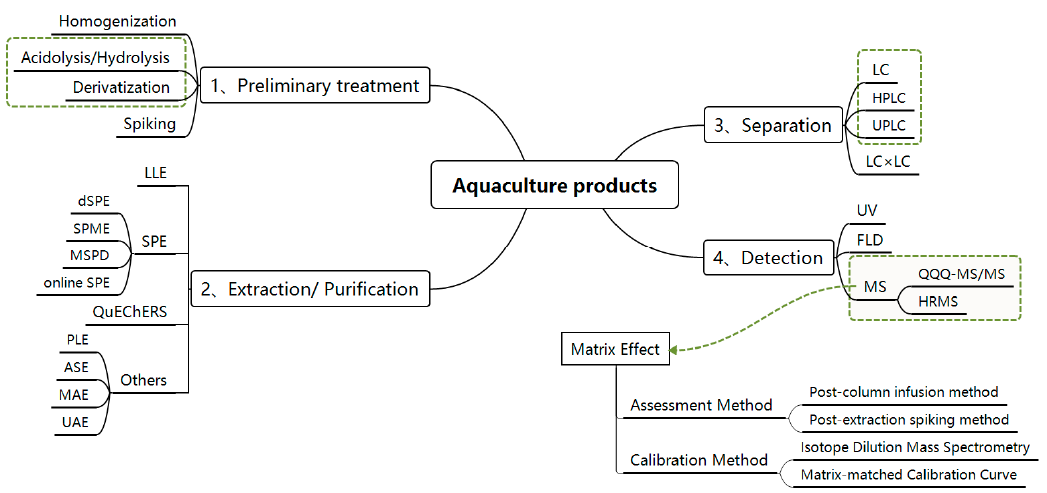
Figure 1. The main steps of the analytical procedure applied in determination of antibiotics of aquaculture products.